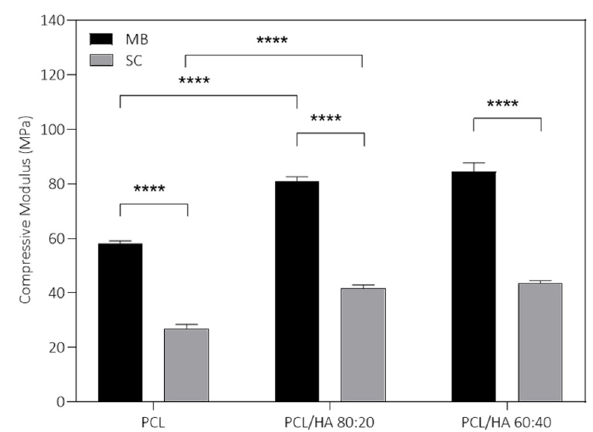
Figure 6. Compressive modulus obtained for the produced scaffolds by MB and SC. The results are presented in mean ± SE. Differences were considered statistically significant at p ≤ 0.05. Results’ significance is presented through the symbol (*), according to the p value, with four symbols, corresponding to p ≤ 0.0001. Table 2. Mechanical properties of compressive strength of scaffolds.